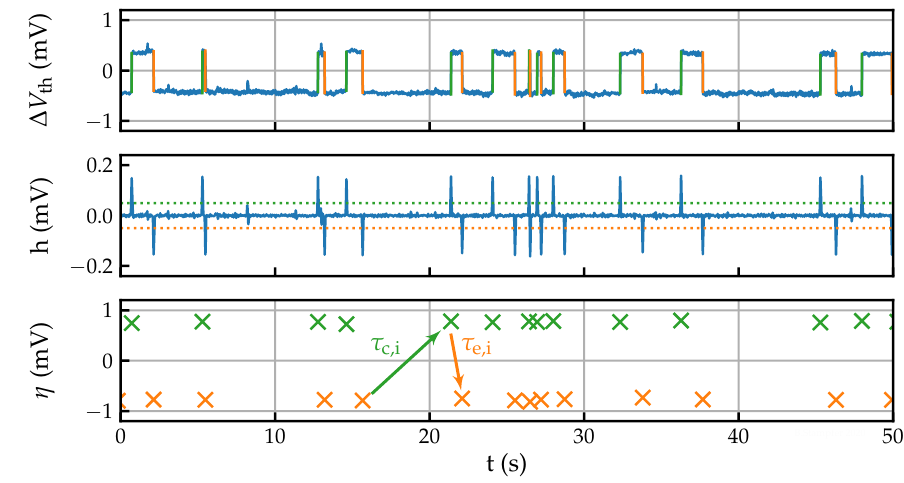
Figure 4. Noise parameter extraction using the Canny algorithm. To find steps in a ∆ V th trace, it is convoluted with the first derivative of a Gaussian pulse. This yields a signal h , as shown in the center panel, with peaks at the positions of the steps. Thresholding is then applied to h to suppress noise. Finally, the positions of the steps are obtained from the positions of the local maxima in h . The height of the steps may be obtained either from the peaks in h or from the original trace. The result is a list of steps ( t i , η i ) from which, ideally, the average step height η , capture time τ c , and emission time τ e for each defect can be